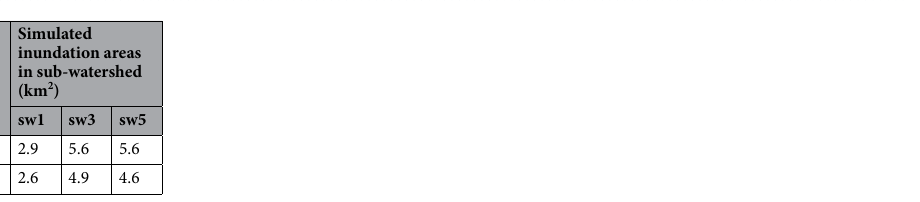
Table 3. Summary of the calculated inundation areas during 2013 typhoon Wipha in sub-watersheds 1, 3, and 5.